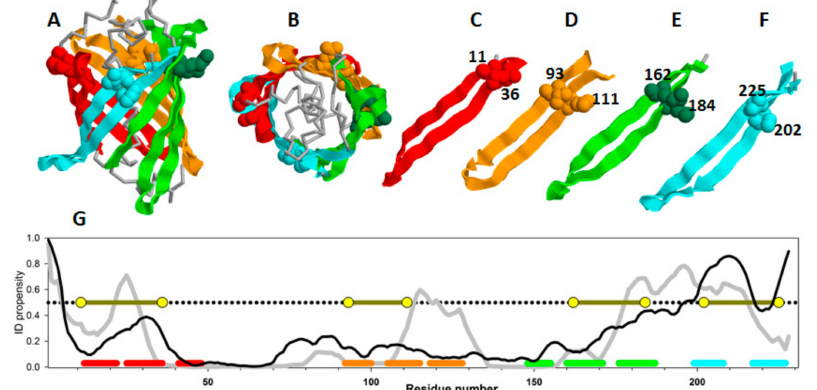
Figure 3. The three-dimensional structure of GFP: Side view ( A ) and top view ( B ), β -strands of the protein colored red, yellow, green, and cyan, respectively. β -hairpins selected for insertion of disulfide bonds are shown separately ( C – F ). Amino acid residues substituted to cysteine are shown as spheres their numbers are labeled on the figure. ( G ) ID propensity plots calculated by PONDR ® FIT (gray line) and IsUnstruct (black line). The corresponding colored lines at the bottom of the plot highlight the positions of beta-hairpins selected for the study. Yellow circles show the positions of disulfide bond